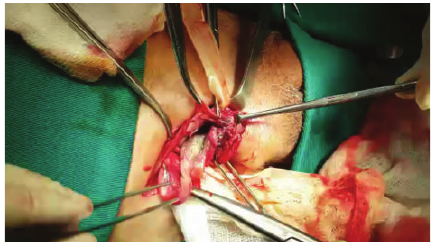
Figure 3: Cecal appendix with inflammatory signs composing the hernia sac.